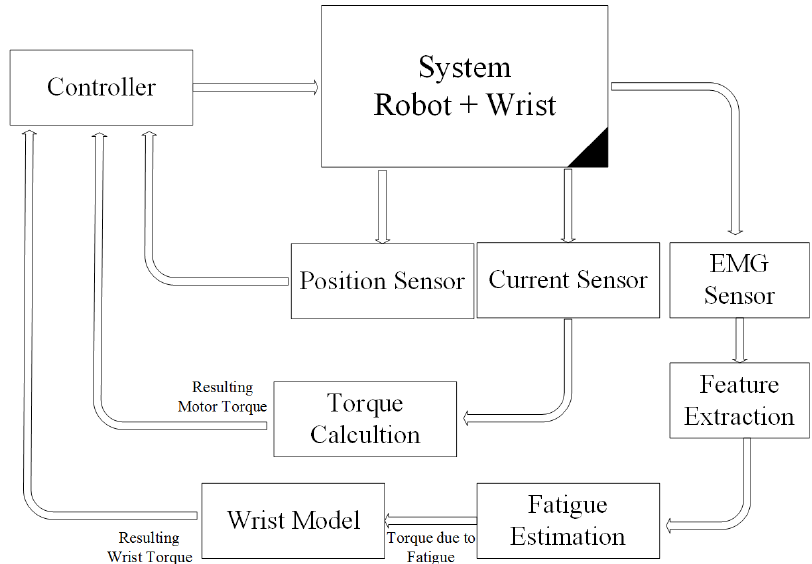
Figure 7. Loaded robot control architecture.